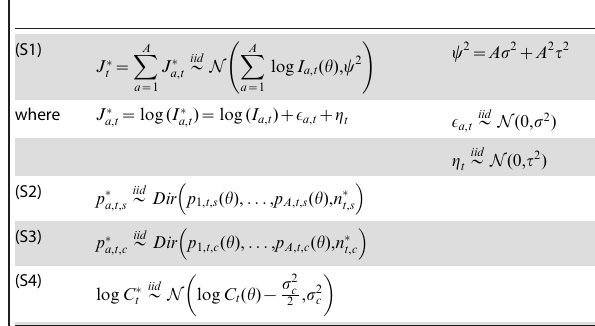
Table 4. Observation equations for the SIMCAB estimation model. iid: independent and identically distributed; * : distributed as; N : normal distribution; Dir : Dirichlet distribution.